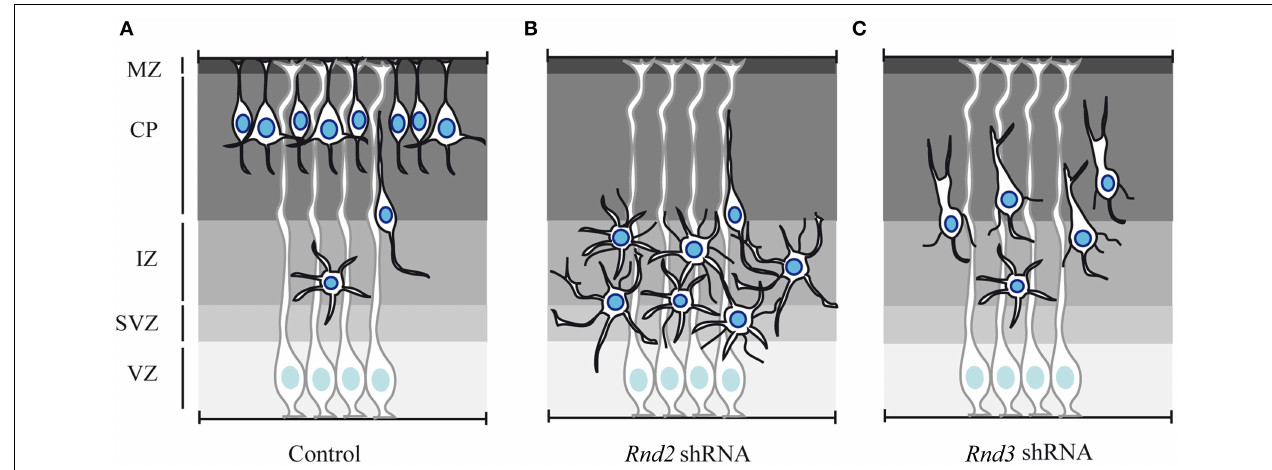
FIGURE 3 | Effect of Rnd2 and Rnd3 loss of function on cortical neuron migration. (A) Schematic representation of cortical radial migration in control condition. Newborn projection neurons undergo sequential steps of radial migration, which are characterized by distinct morphologies. At mid-end corticogenesis most of the neurons have reached the CP. Only few cells are still migrating and they exhibit multipolar morphology in the IZ and bipolar shape in the CP. (B) shRNA-mediated loss of function of Rnd2 expression